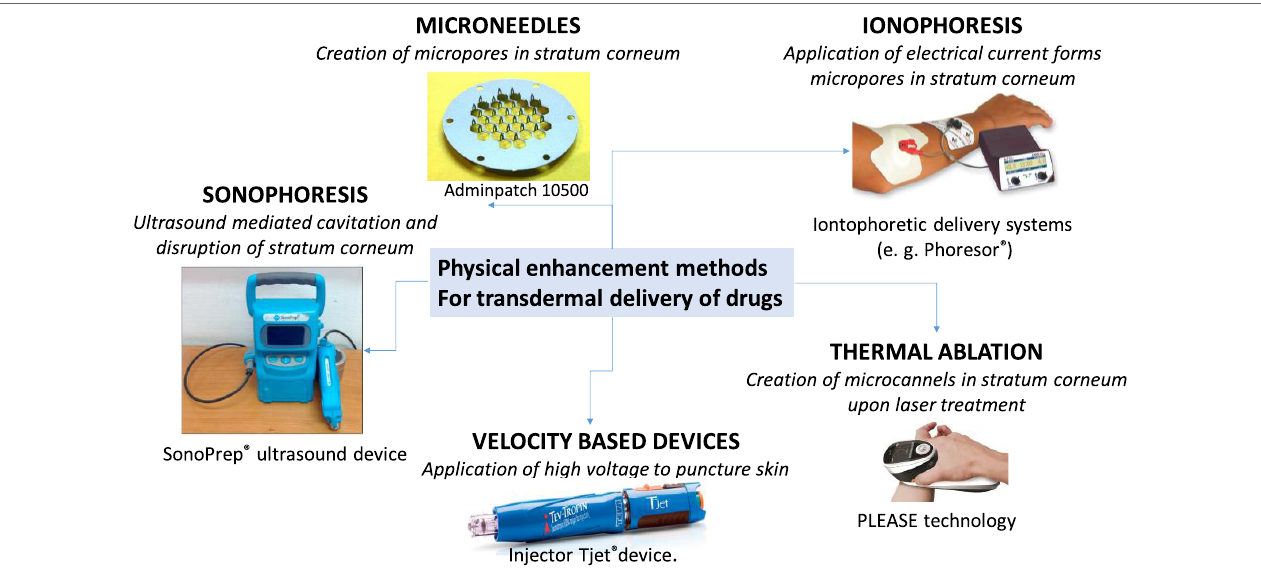
FigURe 2 | Physical enhancement approaches for transdermal drug delivery together with some examples of commercially available products and their mode of